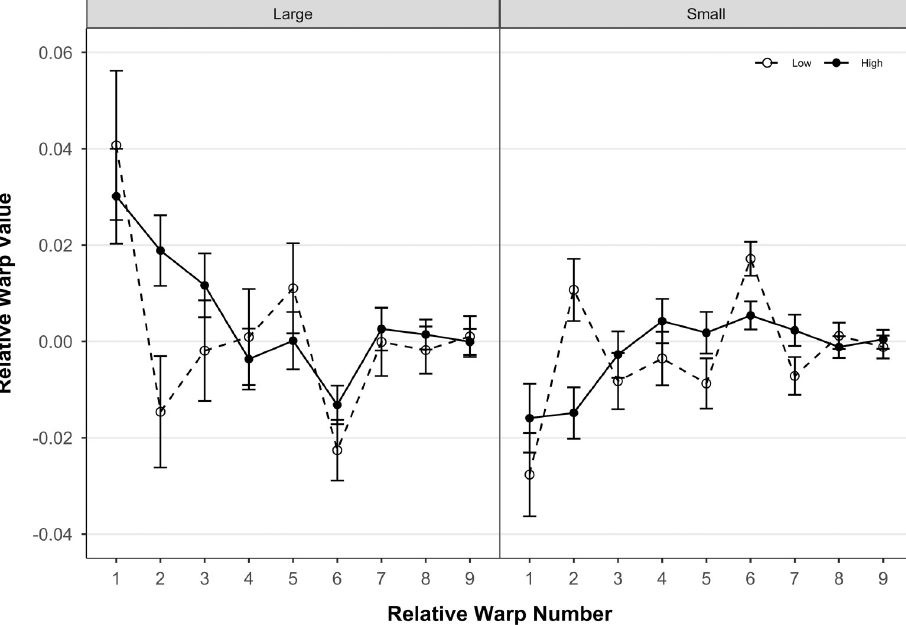
Fig 5. Relative warp least squares means for head. Least squares means (error bars represent 95% confidence intervals of the mean) for each of 9 relative warps from the multivariate linear mixed model of head shape variation of T . areolatus . The high-velocity environment is represented by closed circle symbols and solid connecting lines, and the low-velocity environment is represented by open circle symbols and dashed connecting lines. Small and large ontogenetic stages are represented by centroid sizes of 5.00 and 20.00,